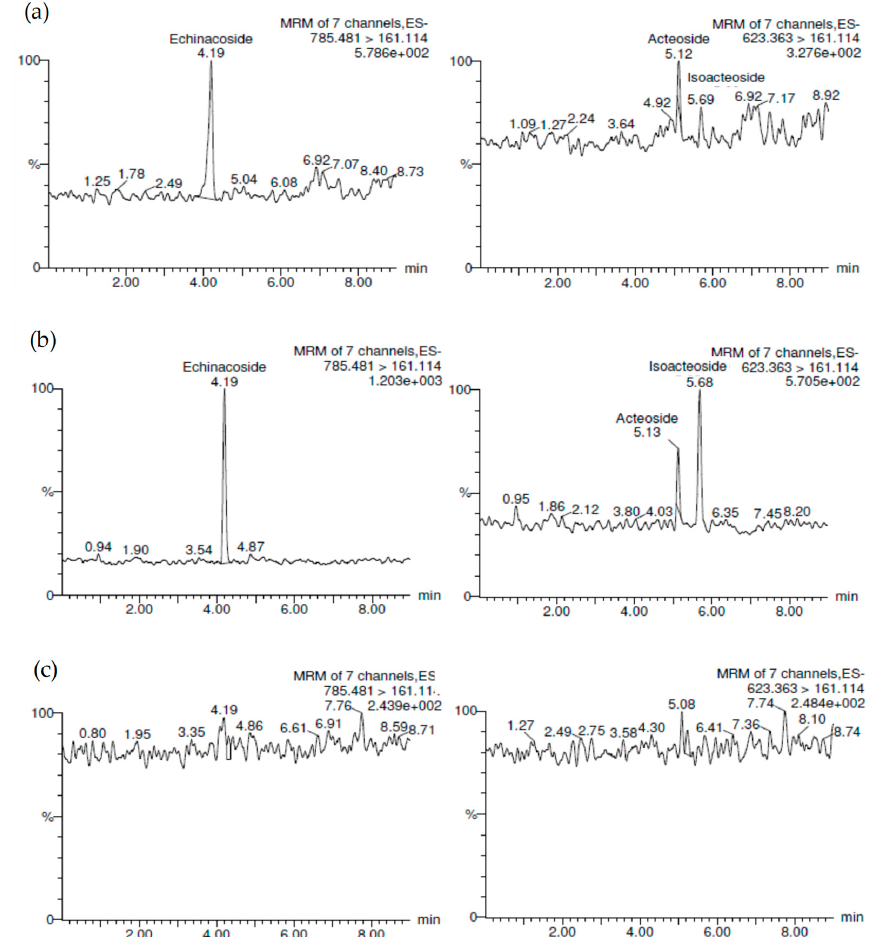
Figure 3. The UPLC/MS/MS chromaotograms for phenylethanoid glycosides ( 1 – 3 ). ( a ) hippocampus samples from Alzheimer’s disease (AD)-like rats after Cistanche tubulosa aqueous extract (CTE) oral administration (200 mg/kg, p.o.) [ 1 ( t R = 4.19 min), 2 ( t R = 5.12 min) and 3 ( t R = 5.69 min)]. ( b ) Striatum sample from AD-like rats after CTE oral administration (200 mg/kg, p.o.) [ 1 ( t R = 4.19 min), 2 ( t R = 5.13 min) and 3 ( t R = 5.68 min)]. ( c ) Blank brain